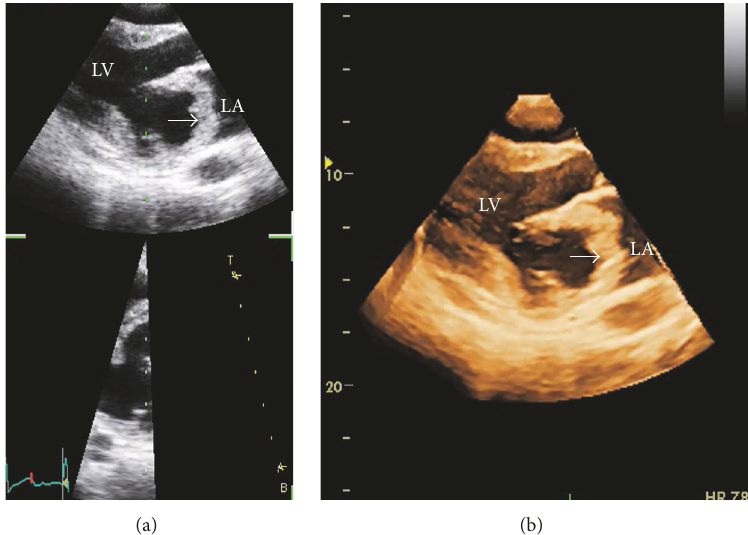
Figure 1: Transthoracic 2D (a) and 4D (b) echocardiographic views in parasternal long axis orientation. Parachute-shaped mass (arrows) in LA attached to atrial side of AML and inferoposterior region of left atrial endocardium. LA: left atrium; LV: left ventricle.